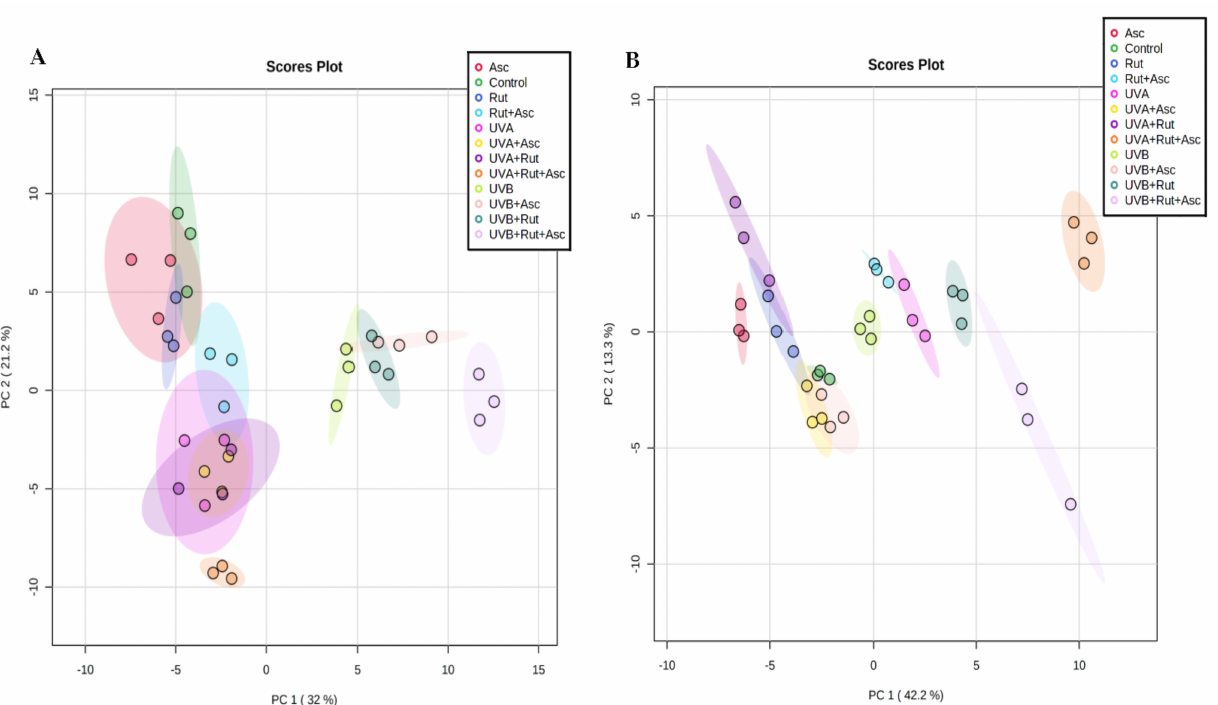
Figure 3. Two-dimensional principal component analysis (2D PCA) scores plot of the relative phospholipid ( A ) and ceramide ( B ) content related to the internal standard of each class within each class in 3D cultured fibroblasts: not treated (Control); treated with ascorbic acid (Asc); treated with rutin (Rut); treated with rutin and ascorbic acid (Rut+Asc); exposed to UVA (UVA); exposed to UVA and treated with ascorbic acid (UVA+Asc); exposed to UVA and treated with rutin (UVA+Rut); exposed to UVA and treated with rutin and ascorbic acid (UVA+Rut+Asc); exposed to UVB (UVB); exposed to UVB and treated with ascorbic acid (UVB+Asc); exposed to UVB and treated with rutin (UVB+Rut); exposed to UVB and treated with rutin and ascorbic acid